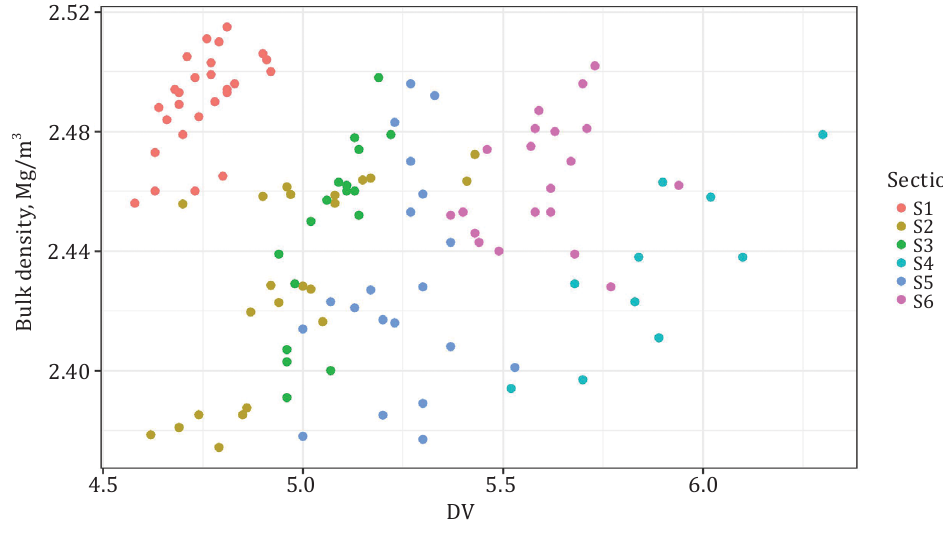
Figure 7. Scatter plot between DV and Core D in all test